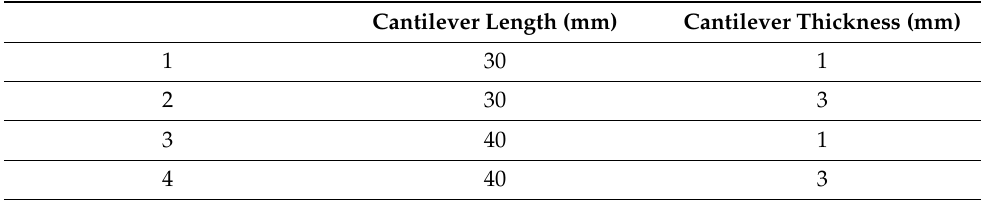
Table 2. Configuration of the systems used for lab calibration.